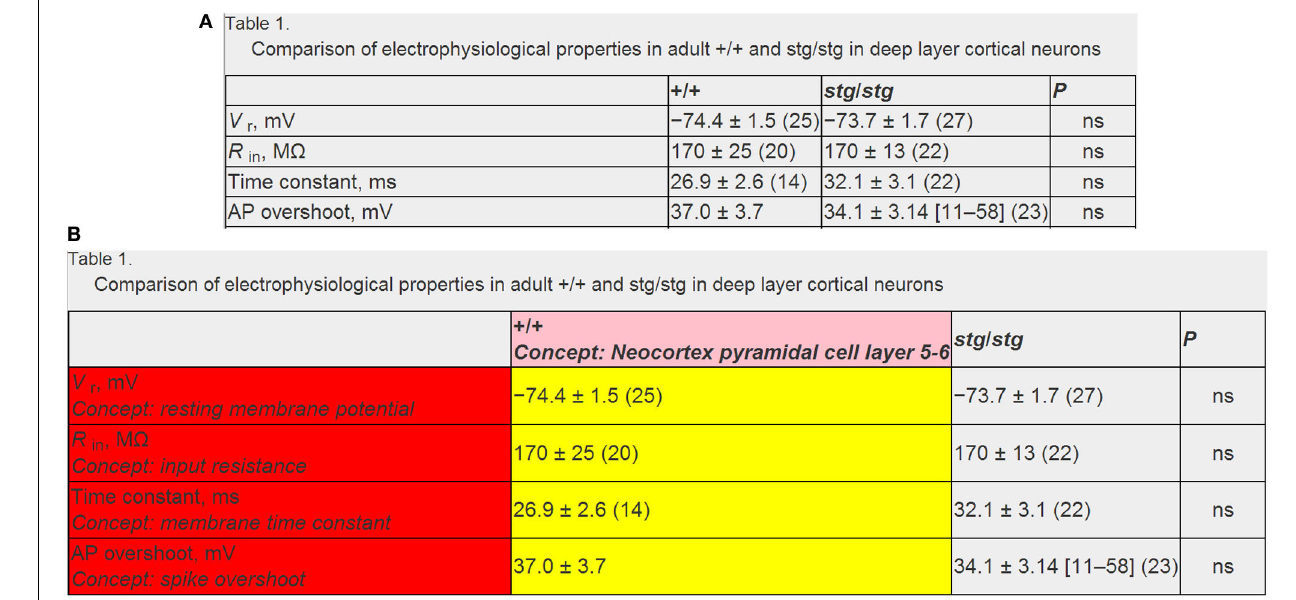
Markups in red and pink indicate electrophysiological and neuron type concepts and yellow indicates extracted data measurements. Note that here the textual string “ + / + ” and “stg/stg” refers to the normotypic and manipulated condition, respectively. Panels (A) and (B) reflect screenshots taken from NeuroElectro web